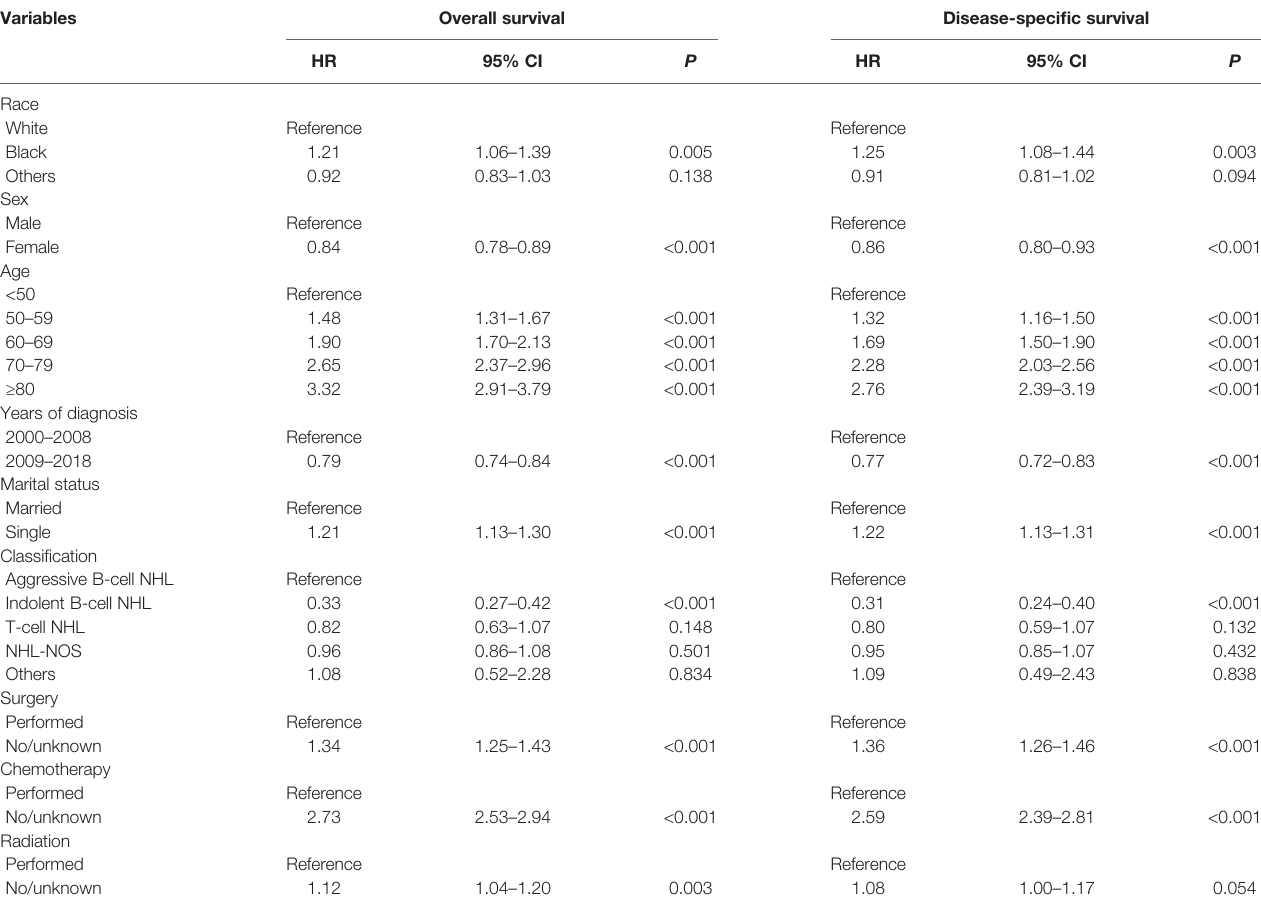
TABLE 3 | Multivariable Cox regression analysis of the independent prognostic factors for OS and DSS among PCNSL patients.